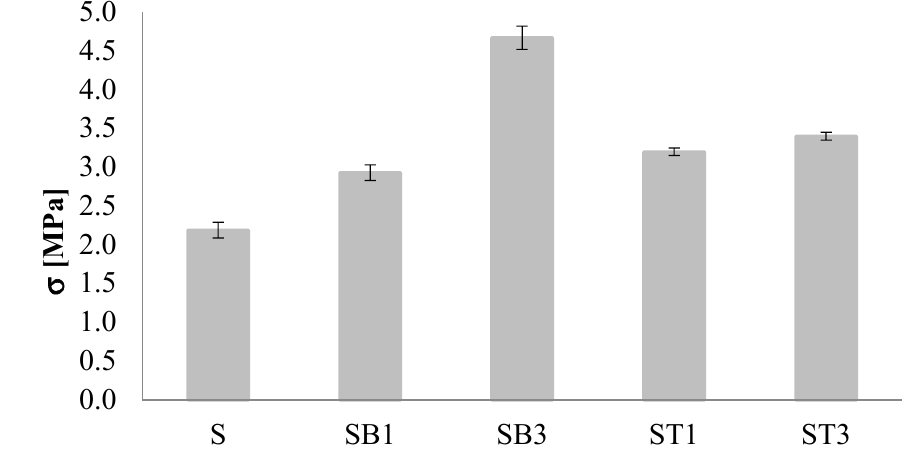
Figure 8. Tensile strength of Sylgard and its composites.